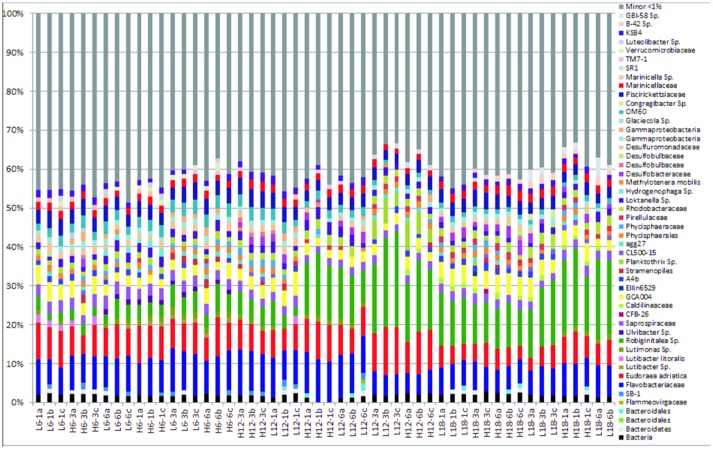
Relative abundance of bacterial community compositions for 52 sediment samples at species level, including taxonomic identification for only sequences that comprised >1% of the total bacterial community for each sample. “Minor” species are all species that comprise < 1% of the total bacterial community for each sample, which have been artificially clustered together into a “minor” species group, depicted by the gray coloring.